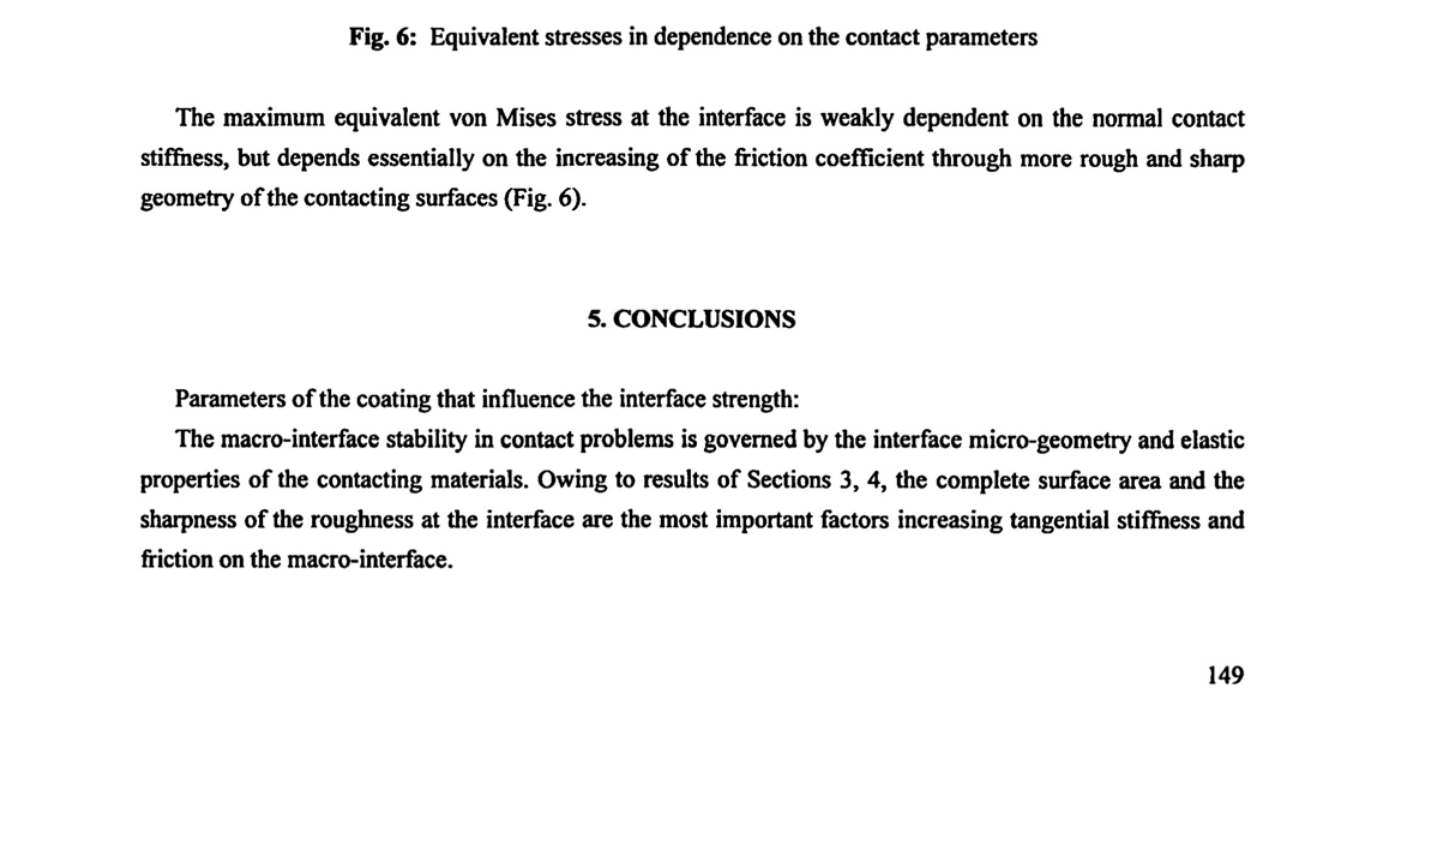
Fig. 6: Equivalent stresses in dependence on the contact